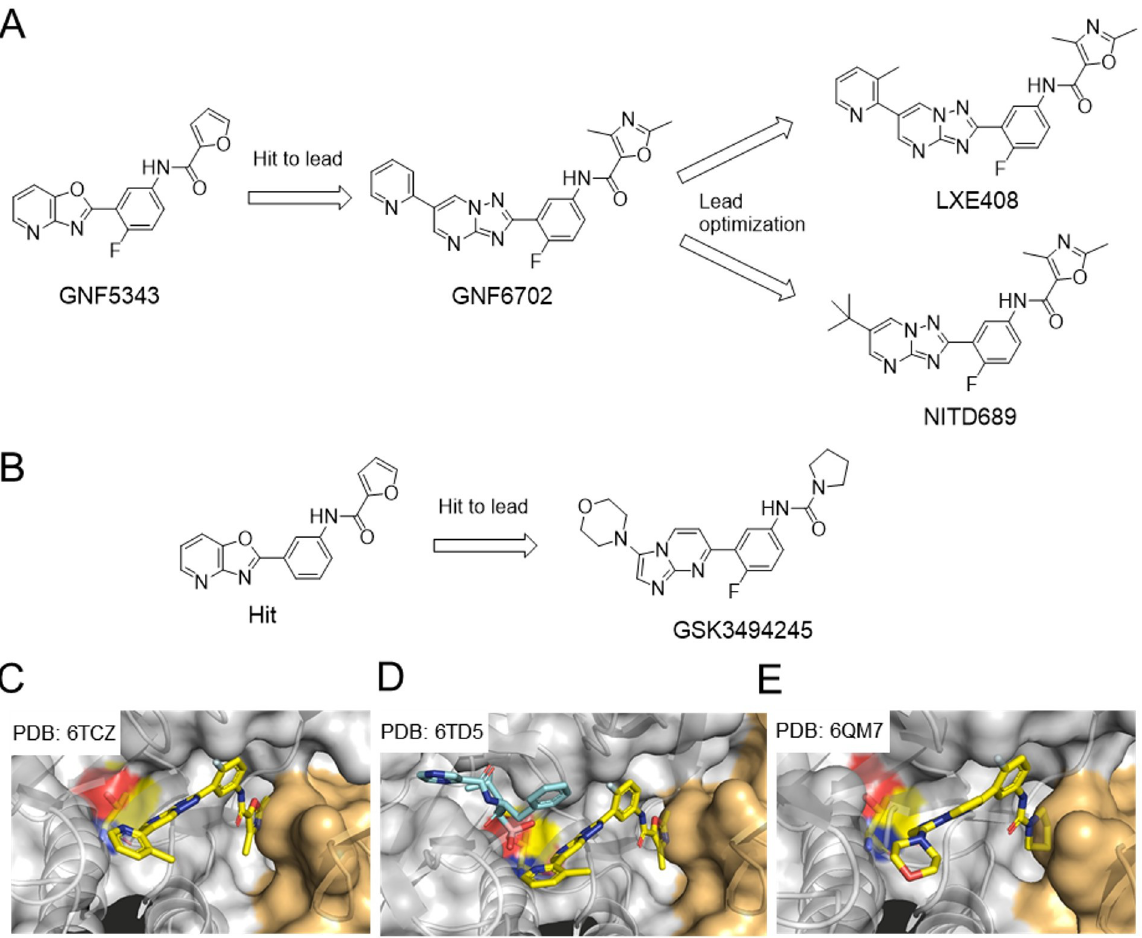
Fig 5. Development of preclinical candidates LXE408 (A) and GSK3494245 (B AU : PleaseconfirmthattheeditstothesentenceDevelopmentofpreclinicalcandidatesLXE 408 ð A Þ andGSK 3494245 ð B Þ ; which ::: didnotaltertheintendedthoughtofthesentence : ), which selectively targets the kinetoplastid proteasomes. Cryo-EM structures show that LXE408 ( C ; PDB: 6TCZ) and GSK3494245 ( D ; PDB: 6QM7) bind to the intersection of β 4 (orange) and β 5 (white) of the Leishmania tarentolae 20S, respectively [85,86]. Cryo-EM structure of L . tarentolae 20S with both bortezomib (cyan) and LXE408 (yellow) is shown in E (PDB: 6TD5) [85]. Active site Thr is shown in